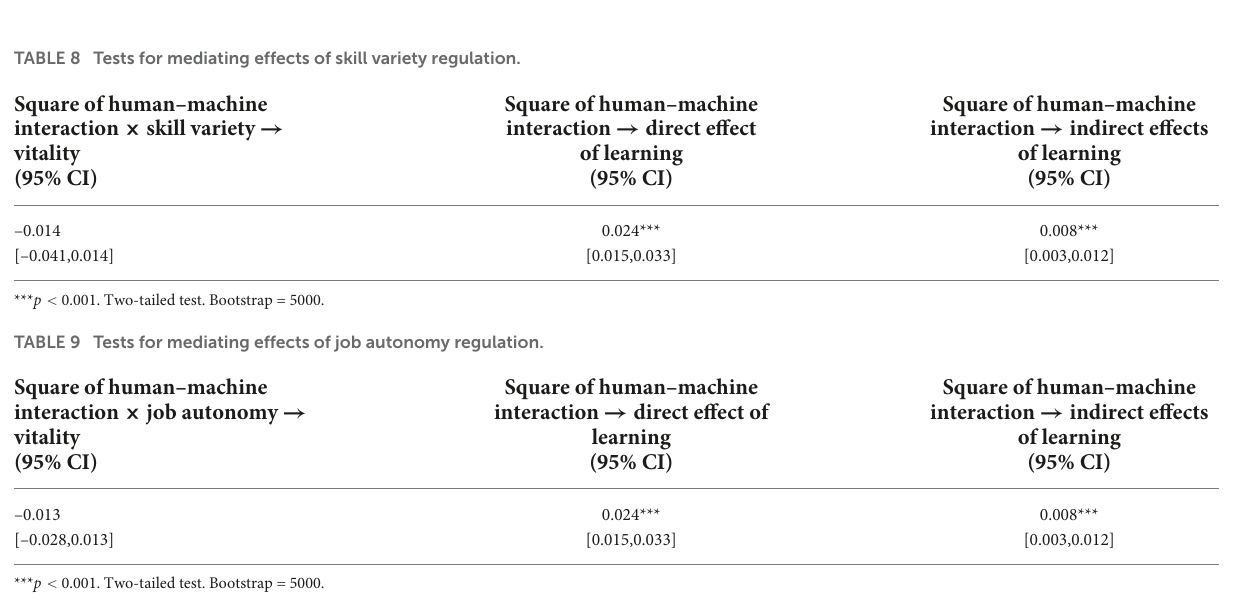
TABLE 10 Simple estimates of the slope of the moderating